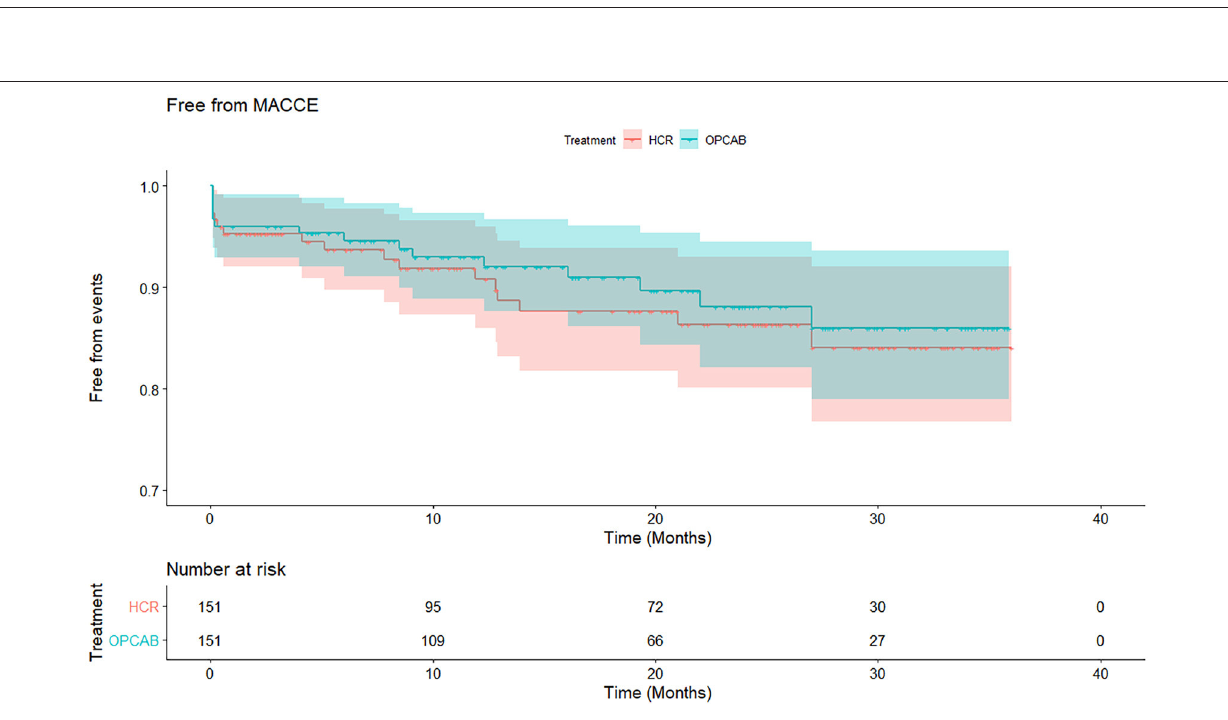
Frontiers in Cardiovascular Medicine |